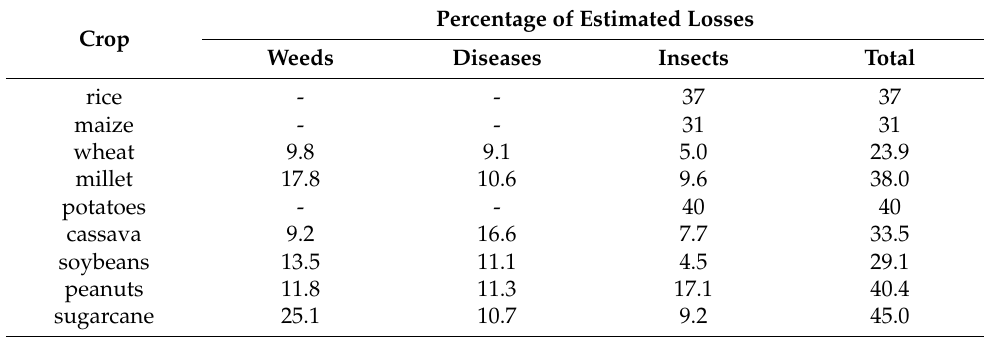
Table 2. Estimation of percentage losses of major crops due to pests per year